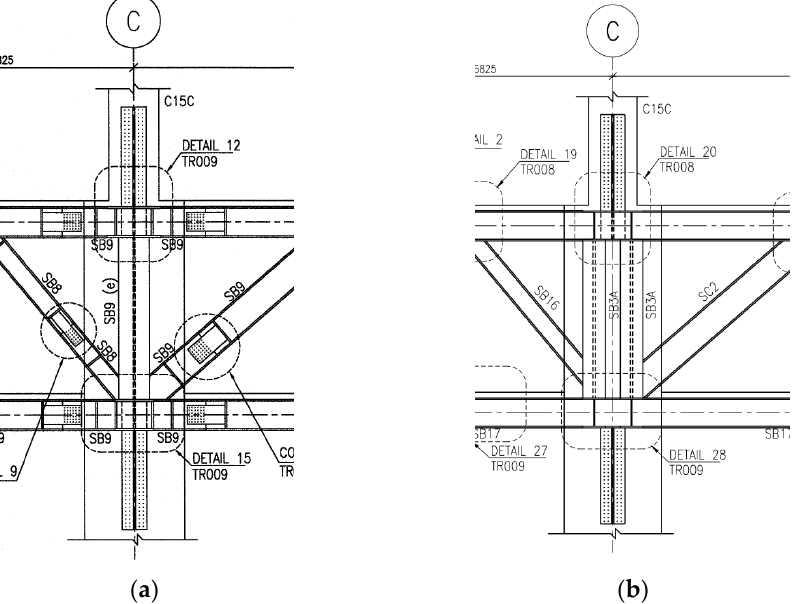
Figure 6. Original and optimized joint connection details. ( a ) Original design: welded and bolted; ( b ) Optimal design: welded.